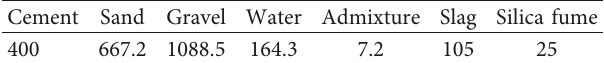
Table 2: Composition of reference concrete (kg · m − 3